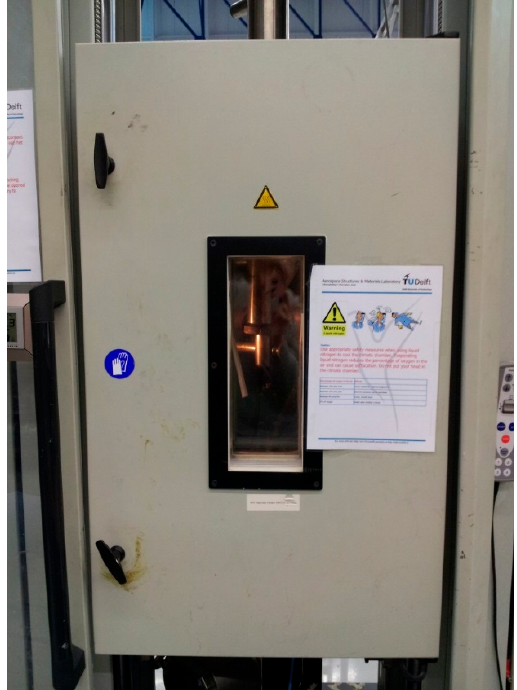
Figure 2. Climate chamber during short-beam tests.